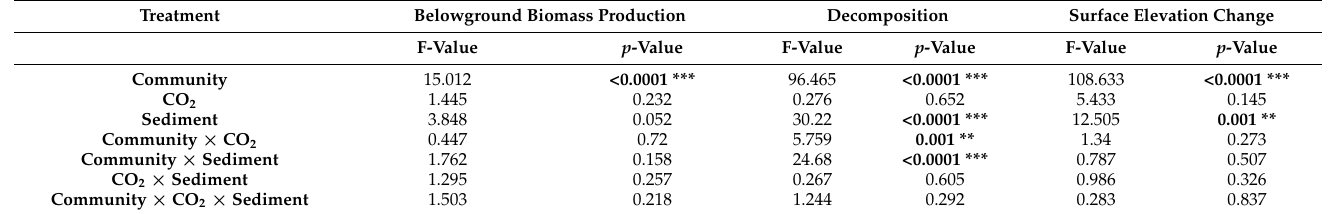
Figure 2. Annual aboveground biomass production of Nyssa biflora (circles) and Schoenoplectus americanus (triangles) by community and CO 2 (ambient: black, elevated: magenta). ( A ) No sediment deposition. ( B ) Sediment deposition. Response variable values are model-based estimated marginal means using Satterthwaite approximation. Brackets represent 95% confidence intervals, p = 0.052 for full interaction: Species × Community × CO 2 × Sediment. Table 2. ANOVA summary table reporting F- and p -values for main effects and interactions for each of the response variables, belowground primary production, decomposition, and surface elevation change. Significant values in bold. Significance levels: ** p < 0.01, *** p < 0.001. Treatment Belowground Biomass